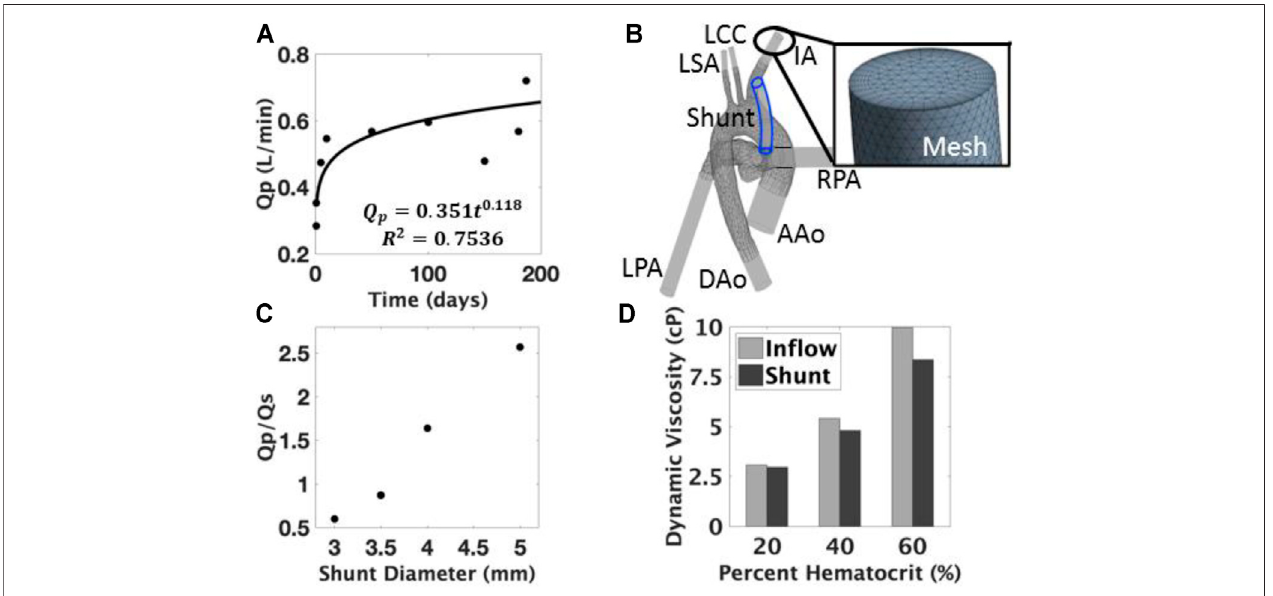
FIGURE 3 | (A) Pulmonary blood fl ow (Qp) model during growth and development; (B) 3D anatomical computational model was developed to include the ascending aorta (AAo), descending aorta (DAo), innominate artery (IA), left common carotid (LCC), left subclavian (LSA), left pulmonary artery (LPA), and right pulmonary artery(RPA); (C) TheeffectofdiameterontheQp/Qsratioshowedanincreasedamountofpulmonary fl owwithlargerdiameters. (D) Theeffectsoftheviscoelasticmodel are measured through the changes in viscosity at varying locations, the difference of which widens with respect to percent